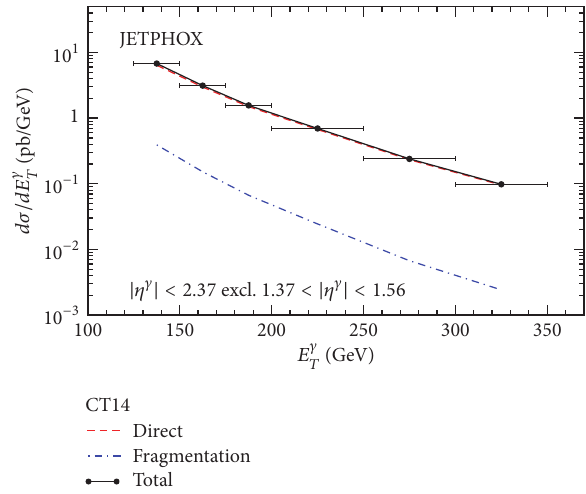
Figure 1: The NLO differential cross section of the isolated prompt photon production in pp collisions at √𝑠 = 13 TeV as a function of 𝐸 𝛾 125 < 𝐸 𝛾 < 350 GeV for |𝜂 𝛾 | < 2.37 𝑇 in the kinematic range 𝑇 excluding the region 1.37 < |𝜂 𝛾 | < 1.56 and using NLO CT14 [92] PDFs. The direct (red dashed curve) and fragmentation (blue dotted-dashed curve) contributions to the total cross section (black solid curve) have been shown,